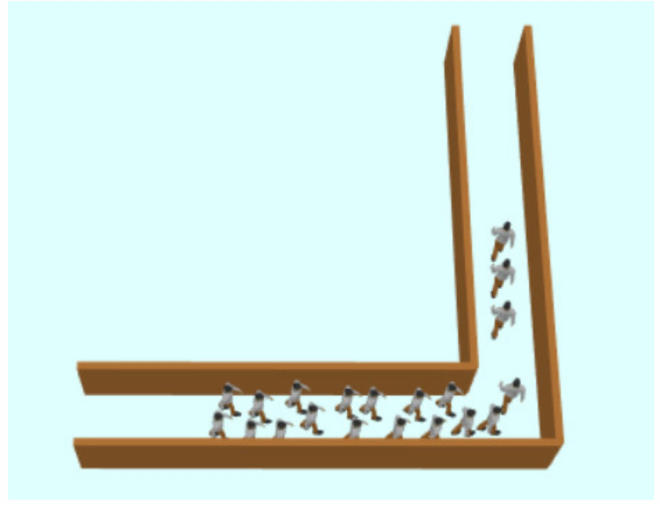
Figure A6. The scenario of test